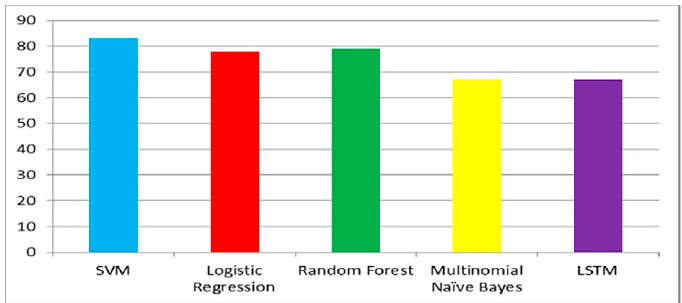
Figure 7. Model accuracy comparison for the post-COVID-19 health factors query.